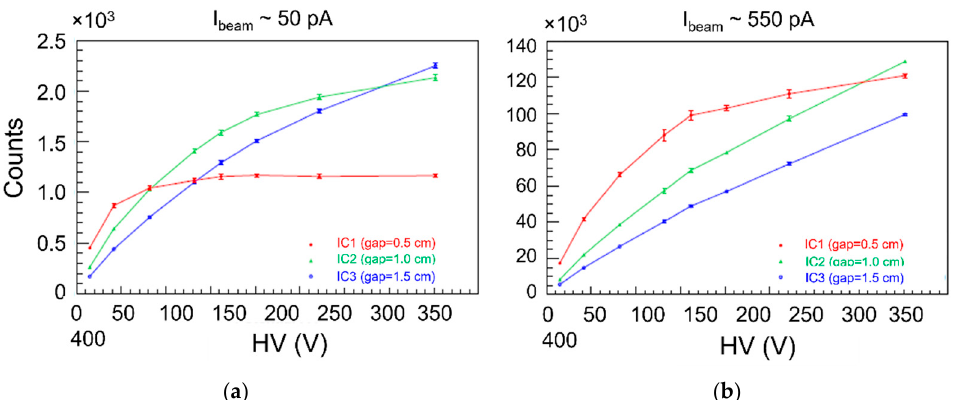
Figure 7. Integral counts measured by the three chambers as a function of the bias voltage for two beam intensities: ( a ) 50 pA and ( b ) 550 pA. beam intensities: ( a ) 50 pA and ( b ) 550 pA.